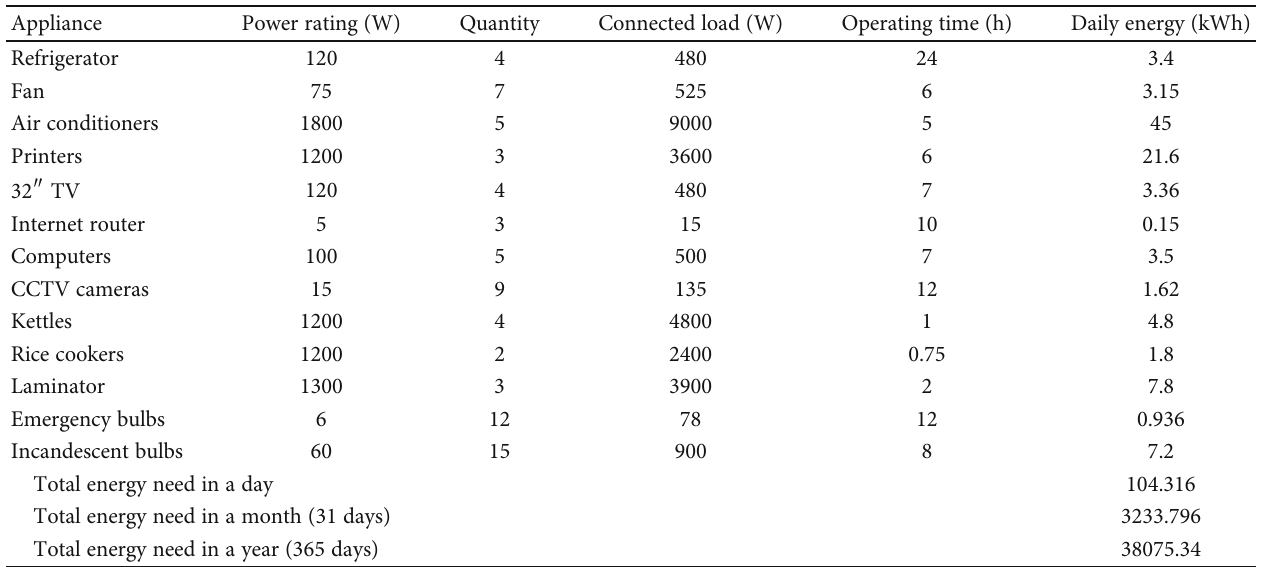
Table 2: Current energy use for the building.